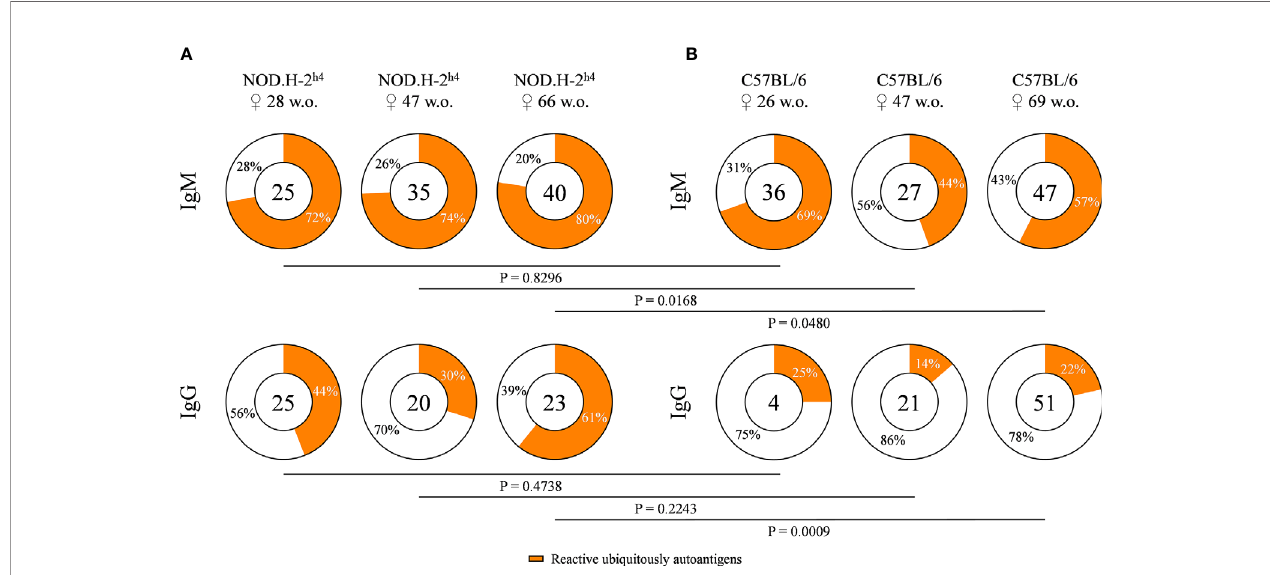
FIGURE 1 | Frequency of autoreactive antibodies derived from NOD.H-2 h4 and C57BL/6J mice. Pie charts showing the proportion of hybridomas that produce autoreactive (orange) or non-autoreactive (white) antibodies determined by fl ow cytometry with murine L cells. Data from NOD.H-2 h4 (age: 28, 47 and 66 w.o.) (A) , and C57BL/6J (age: 26, 47 and 69 w.o.) (B) and both IgM and IgG isotypes are shown. The number of tested antibodies is indicated in the pie chart center. Data are pooled from independent experiments for each mouse age. P-values were calculated by c 2